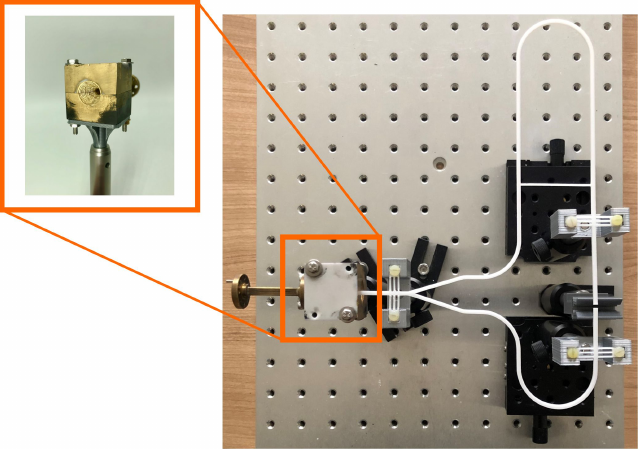
Figure 24. Measurement